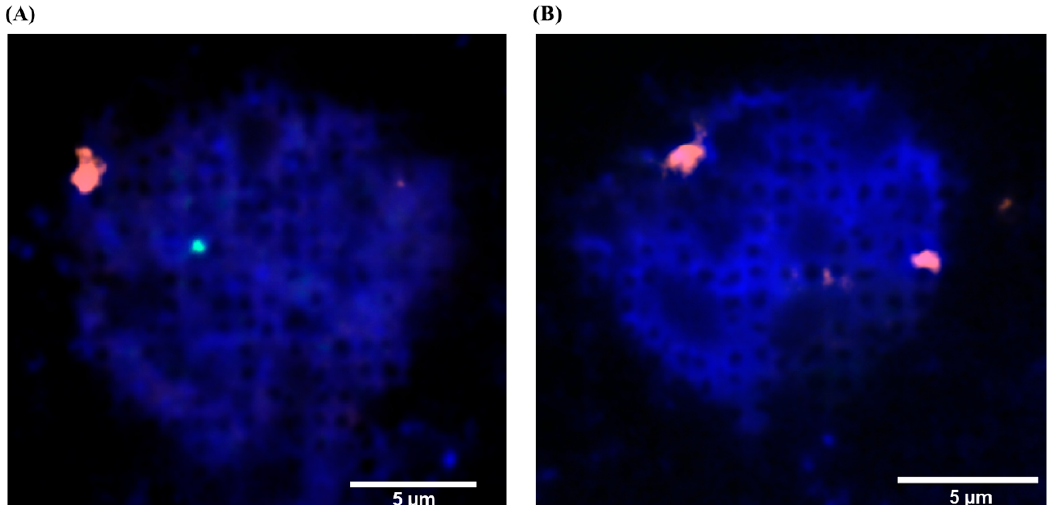
Figure 6. The fluorescent in situ hybridization (FISH) for cells on a Coral Chip. The cells are from the blood of a pregnant women with an euploid male fetus (case 13 in Table 2). The FISH was directly performed on the chip using the CEP X SpectrumOrange/Y SpectrumGreen DNA probe kit (Vysis, Downers Grove, IL, USA). ( A ) The fetal nucleated red blood cell (fnRBC) can be distinguished from ( B ) the maternal white blood cell (WBC) by the signals of chromosome X and Y: the fnRBC has 1 orange and 1 green signal, and the maternal WBC has 2 orange signals.